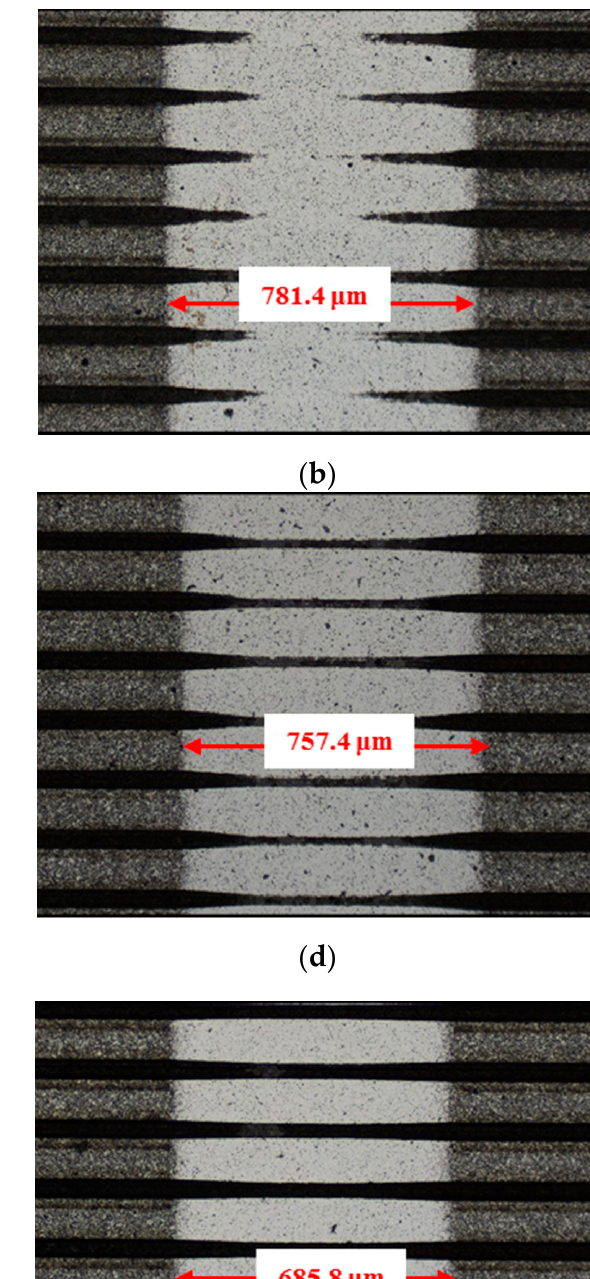
Figure 16. Wear performance of circular-dimple-textured SiC under water-lubricated conditions with a load of 75 N (×10): ( a ) 3 μ m circular-dimple-textured SiC–steel ball, ( b ) 3 μ m circular-dimple-textured SiC–Si 3 N 4 ball, ( c ) 5 μ m circular-dim- ple-textured SiC–steel ball, ( d ) 5 μ m circular-dimple-textured SiC–Si 3 N 4 ball, ( e ) 10 μ m circular-dimple-textured SiC–steel